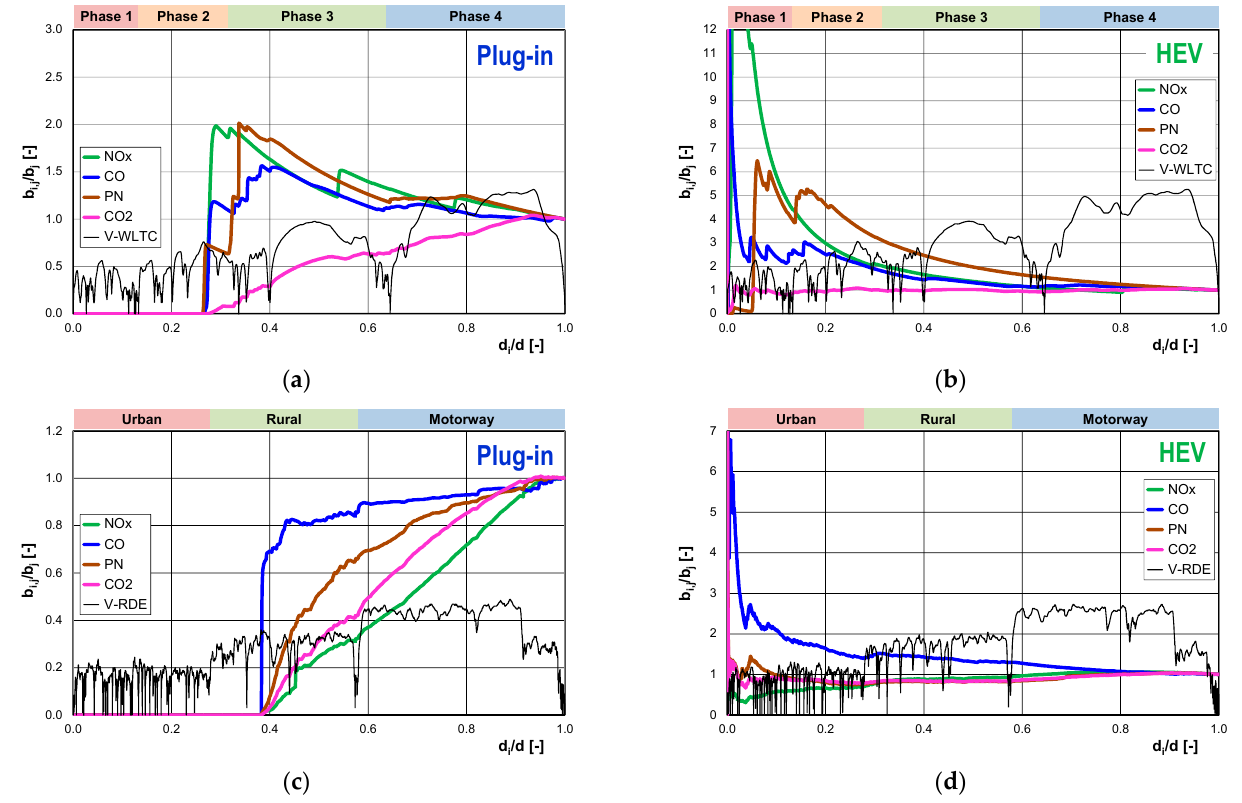
Figure 36. Relative on-road emissions of exhaust compounds of plug-in and HEVs in the RDE test: ( a ) plug-in—WLTC; ( b ) HEV—WLTC; ( c ) plug-in—RDE test; ( d ) HEV—RDE test. The relative on-road emissions for the HEV have a completely different